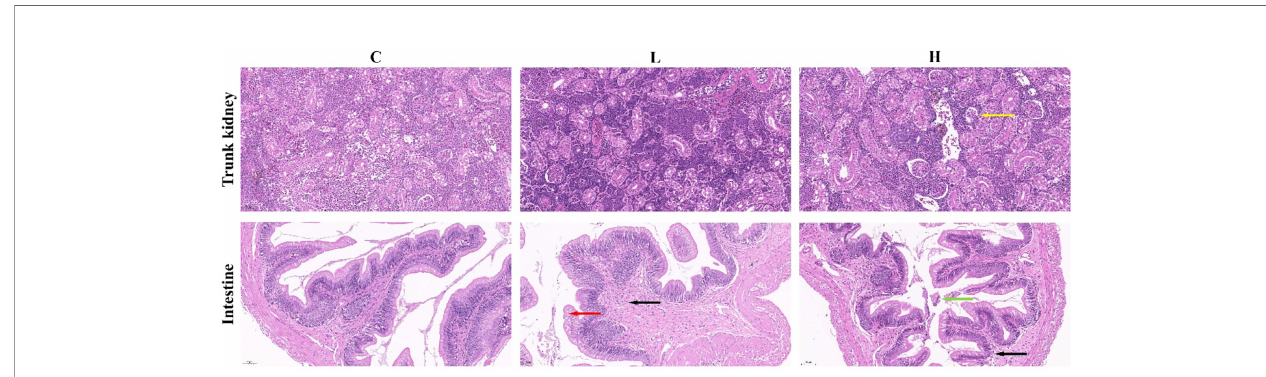
FIGURE 1 | Pathological changes of the intestine and trunk kidney in different groups. Black arrows represent in fl ammatory cell in fi ltration; Red arrows represent edema and degeneration of intestinal chorionic epithelial cells; Green arrows represent the shedding of intestinal chorionic epithelial cells; Yellow arrows represent tubular atrophy and denaturation. C: 0 m g/L Del; L: 0.5 m g/L Del; H: 5 m g/L Del.